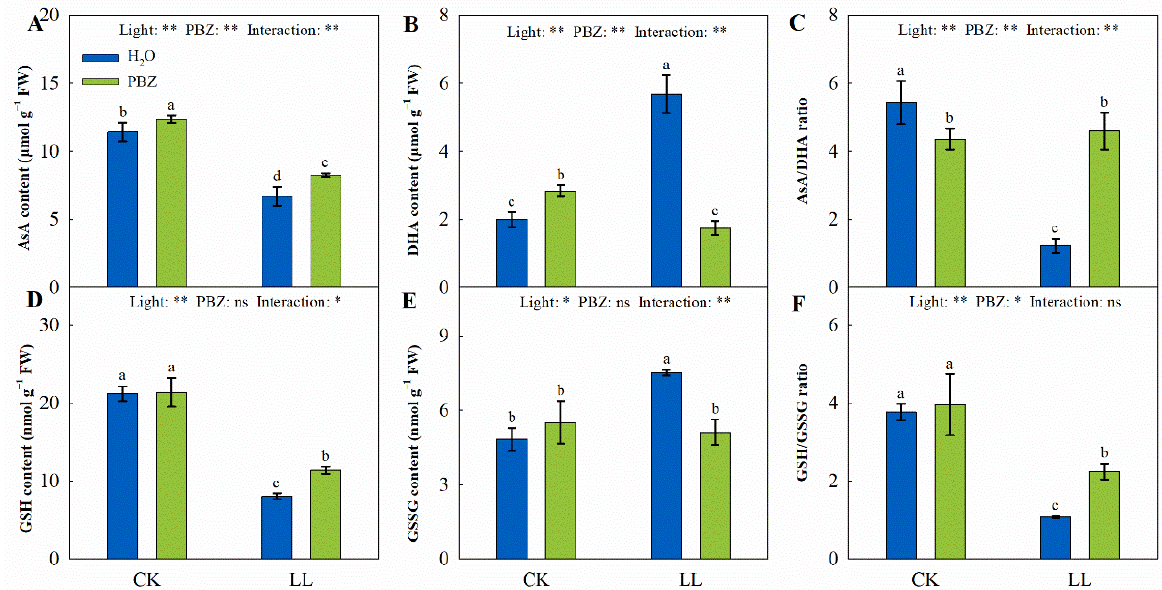
Figure 5. Levels of ascorbate acid (AsA) content ( A ), dehydroascorbic acid (DHA) content ( B ), AsA/DHA ratio ( C ), glutathione (GSH) content ( D ), oxidized glutathione (GSSG) content ( E ), and GSH/GSSG ratio ( F ) of tall fescue leaves induced by paclobutrazol under control (CK) and LL stress. * and ** indicate significant differences at p < 0.05 and p < 0.01, respectively. ns indicates not significant. Different letters above the vertical bars indicate significant differences at p < 0.05 according to Duncan’s multiple range test.